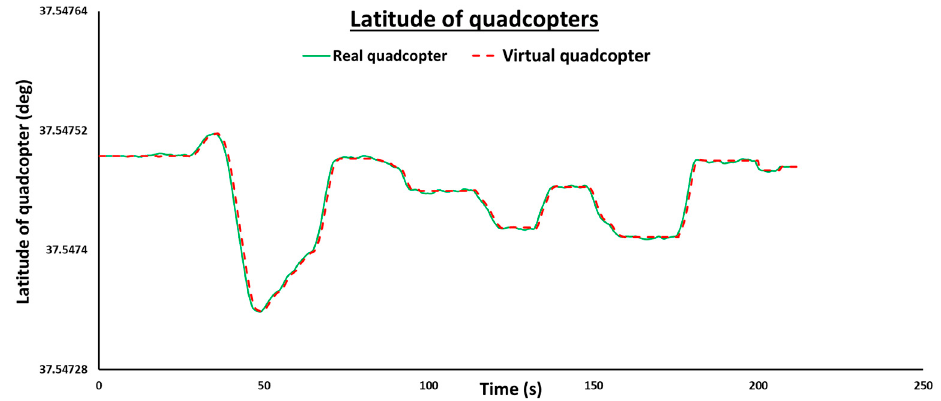
Figure 21. Latitude comparison of the real and the virtual quadcopters.